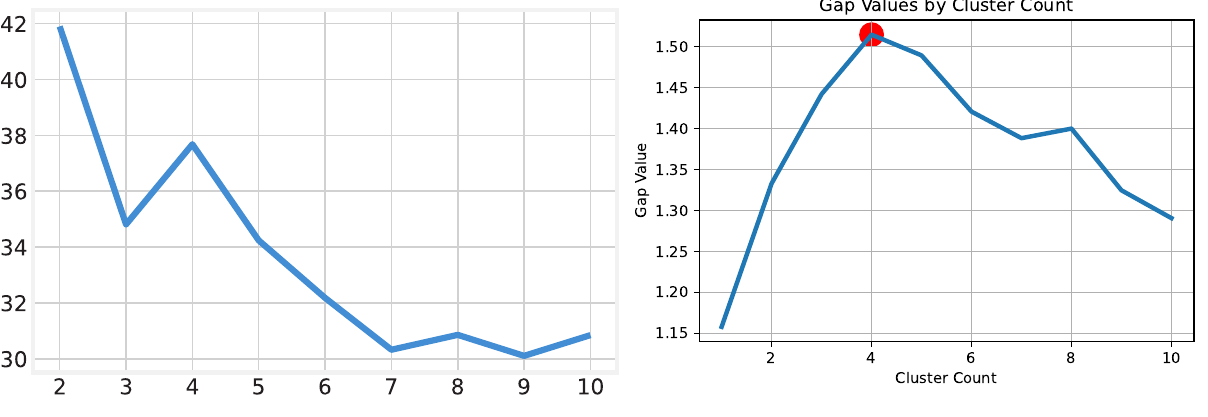
Figure 9. Silhouette Score ( left plot ) and Gap statistic ( right plot ) obtained for clustering results on the three PCs using